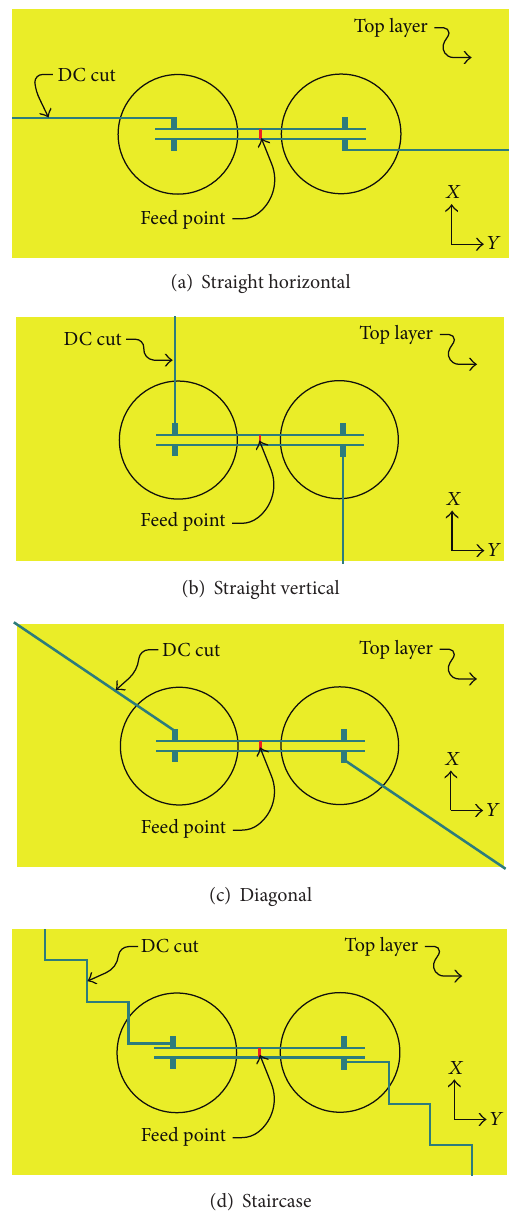
Figure 5: DC cut for top aluminum layer. (a) Straight horizontal, (b) straight vertical, (c) diagonal, and (d)